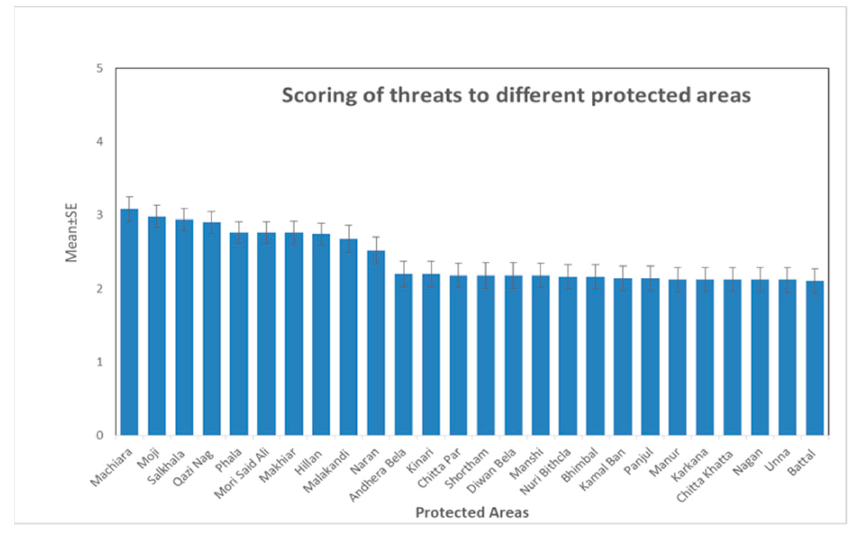
Figure 5. Threats scoring for participating protected areas. ( p < 0.0001) (Figure 6).